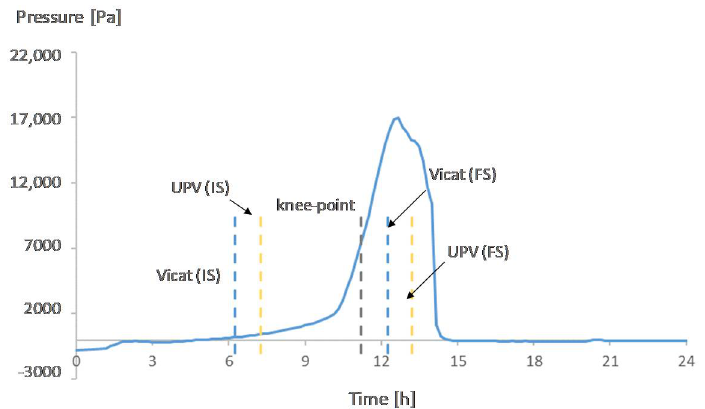
Figure 8. Capillary pressure, setting times, and transition point of SAP1. With IS referring to initial setting and FS referring to final setting.